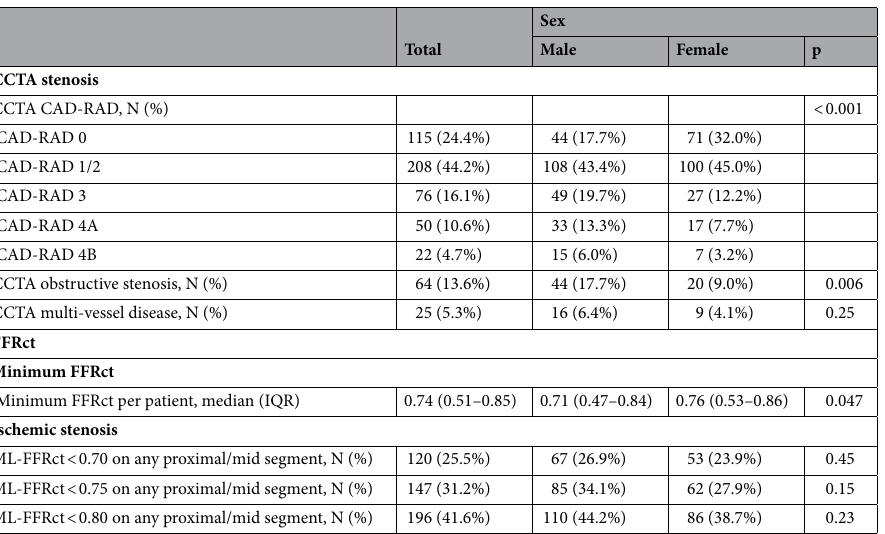
Table 2. Imaging characteristics of the study population by sex. p-value comparing women and men was calculated using Student’s t test for continuous normally-distributed variables and median testing for continuous non-normally distributed variables or chi-square test for categorical variables. CCTA Coronary computed tomography angiography, FFR CT fractional flow reserve derived using computed tomography.